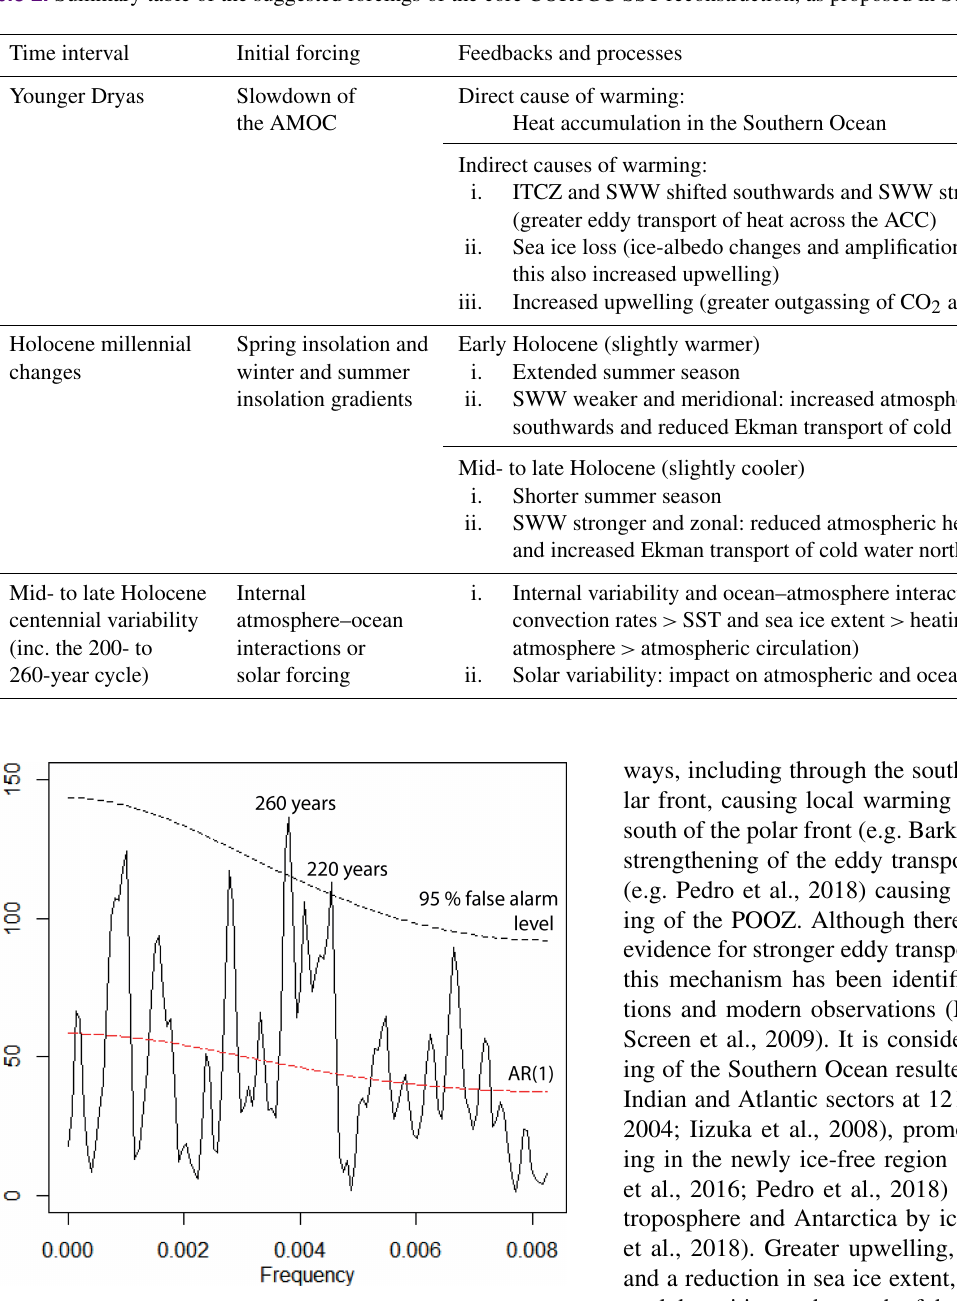
Figure 6. REDFIT spectral analysis of the COR1GC SST recon- struction during the period 12–1ka. The 95% significance level (Chi2) is shown by the dashed black line. The time series is fitted to an AR(1) red noise model (dashed red line).